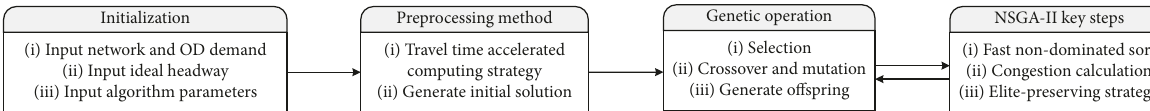
Figure 4: Algorithm framework.